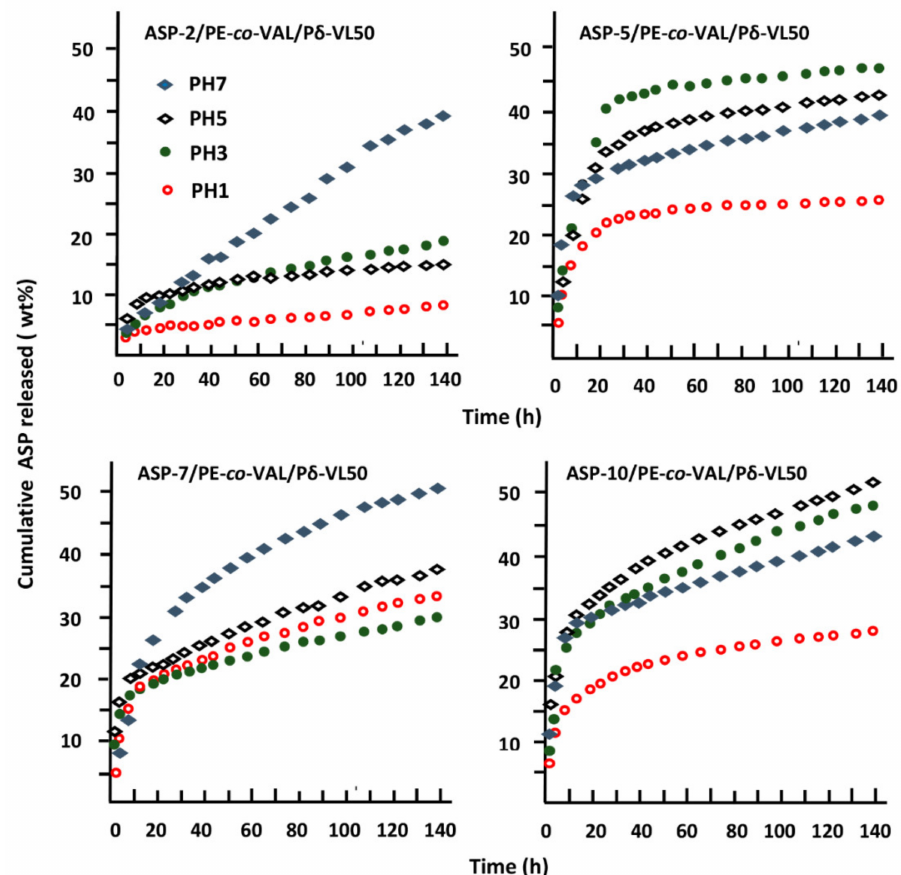
Figure 10. Release dynamic of ASP from the ASP/PE- co -VAL/P δ -VL50 drug-carrier systems versus